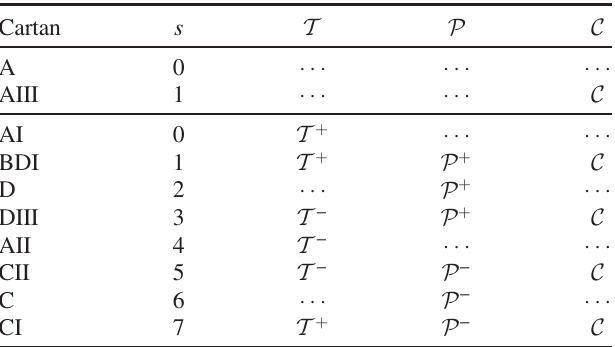
TABLE I. The tenfold-way classes are defined according to the presence or absence of time-reversal symmetry ( T ), particle-hole antisymmetry ( P ), and chiral antisymmetry ( C ). The entries T (cid:2) ( P (cid:2) ) denote that T 2 ¼ (cid:2) 1 ( P 2 ¼ (cid:2) 1 ). The chiral antisymmetry is assumed to square to